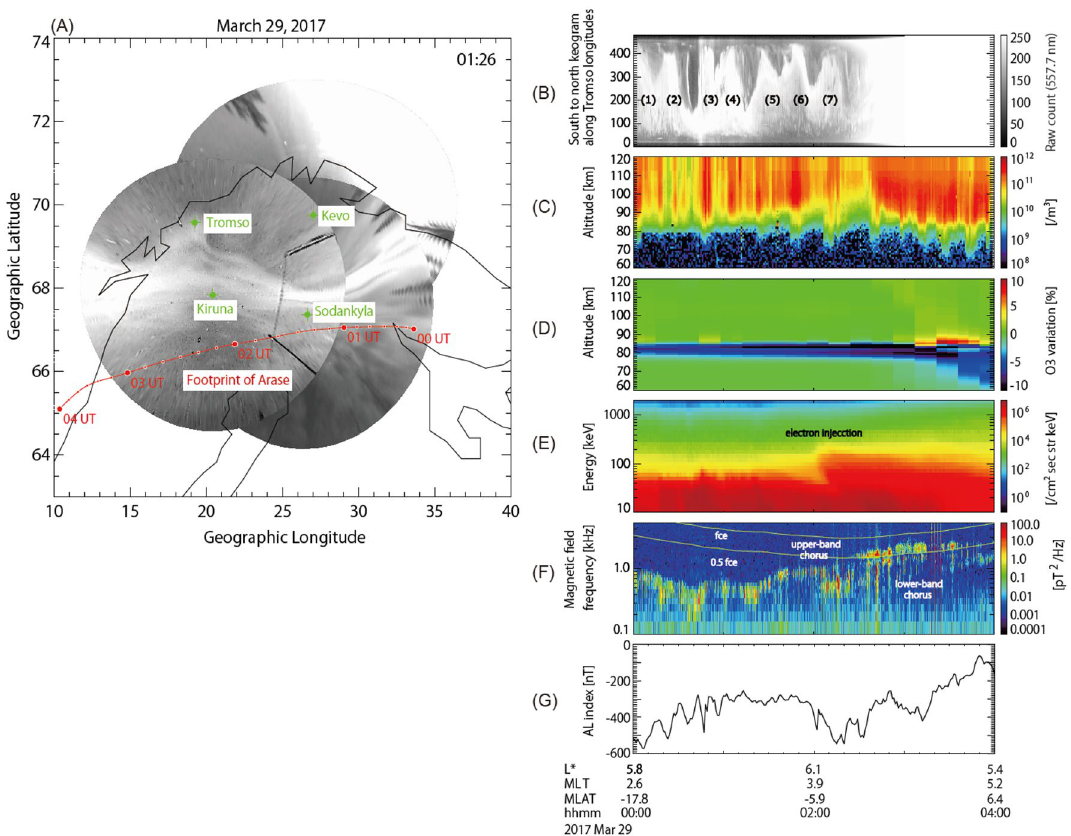
Figure 1. Geospace conditions from the upper atmosphere to the magnetosphere. ( A ) Map around the Scandinavian peninsula with the footprint of Arase from 00:00 UTC to 04:00 UTC on March 29, 2017. Aurora images were obtained from the all sky imager network. ( B ) Keograms of an aurora image along the longitudes of Tromsø, Norway. Labels (1–7) show the “omega-band” structures. ( C ) Electron density profile from a vertical beam of the EISCAT VHF radar at Tromsø, Norway, on March 29, 2017. The horizontal axis represents the universal time; the vertical axis denotes the altitude. The colour bar indicates the electron density. ( D ) Relative O 3 profile from the computer simulation based on the EISCAT observations. The colour bar indicates relative variations from the controlled run without energetic electron precipitations. ( E ) Energy-time diagram of electrons measured by the MEP-e/HEP/XEP instruments onboard the Arase spacecraft. The horizontal axis represents the universal time; the vertical axis denotes the electron energy. Here, MEP-e, HEP, and XEP denote the medium-energy particle—electron, high-energy particle, and extremely high-energy particle, respectively. The colour bar indicates the differential flux of electrons. ( F ) Frequency-time diagram of the magnetic field components of plasma waves measured by the Arase spacecraft. The vertical axis denotes the plasma wave frequency. The colour bar indicates the power spectrum density of the waves. Two lines correspond to the electron gyrofrequency ( f ce ) and their hall frequency ( 0.5 f e ). ( G ) AL index. (IDL ver.8.7, https:// www. l3har risge ospat ial. com/ Softw are- Techn ology/